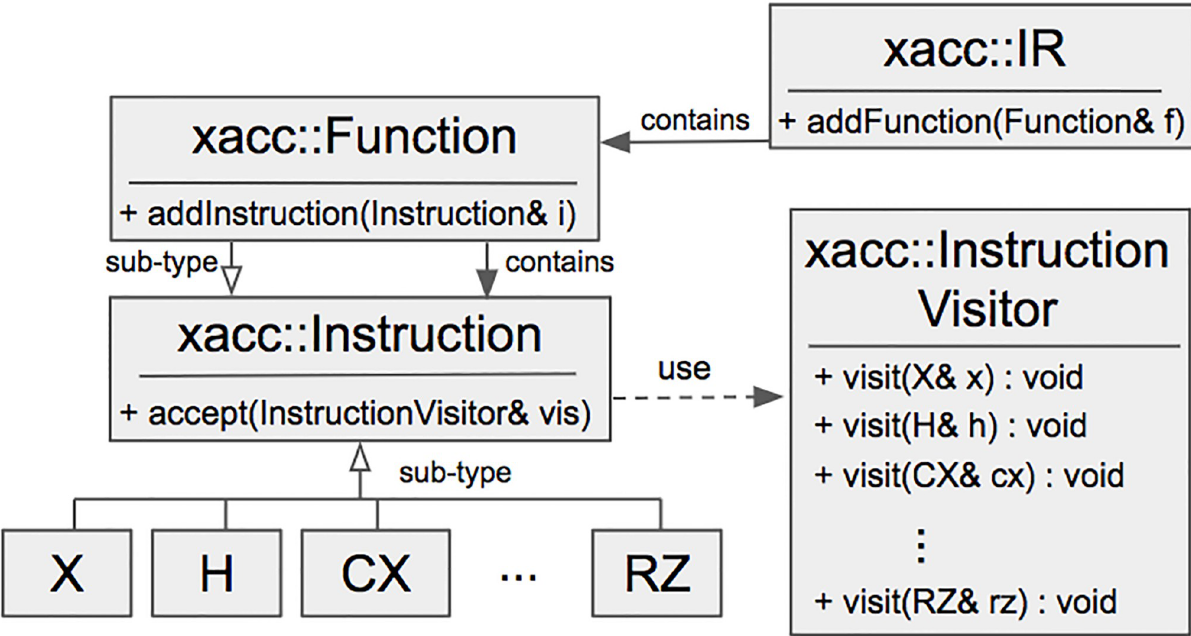
Fig 7. Architecture of the XACC intermediate representation demonstrating sub-type extensibility for instructions, and the associated instruction visitor abstraction, enabling runtime extension of concrete instruction functionality.